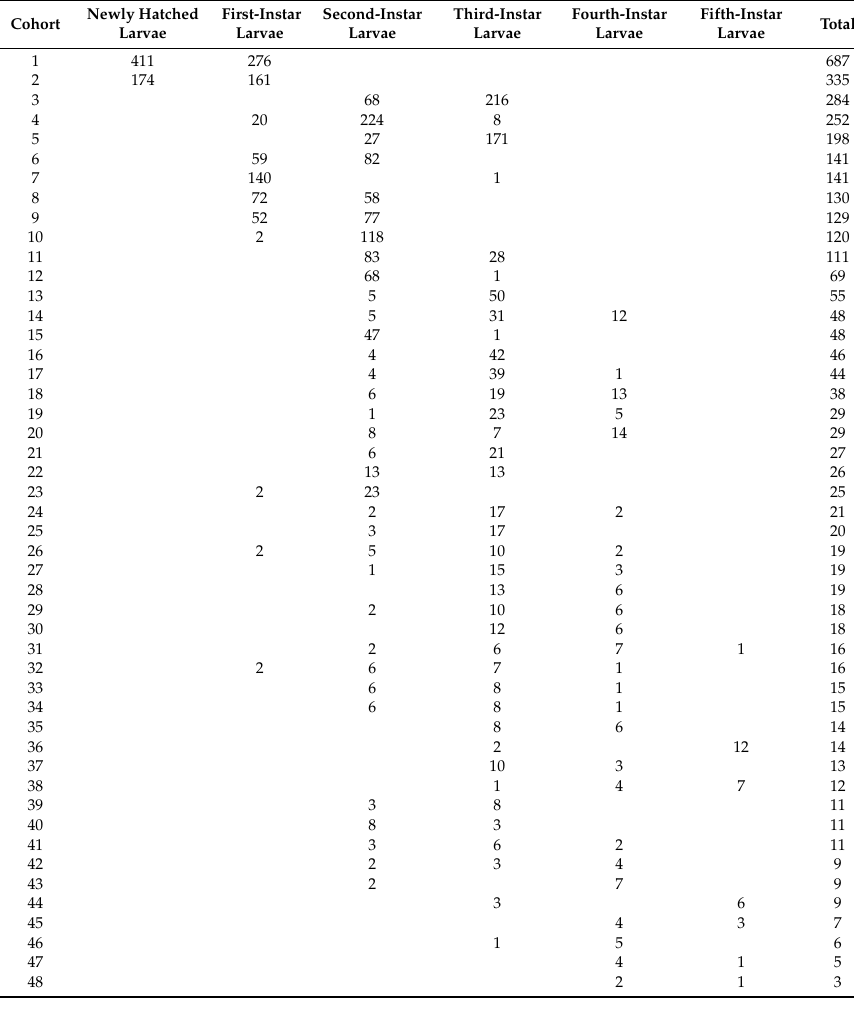
Figure 3. The number of Heortia vitessoides individuals (mean ± SE) in egg clusters and in the cohorts containing the same-instar or different-instar larvae. Different letters indicate significant differences ( p < 0.05). Table 2. The number of larvae in each different-instar mixed cohort.